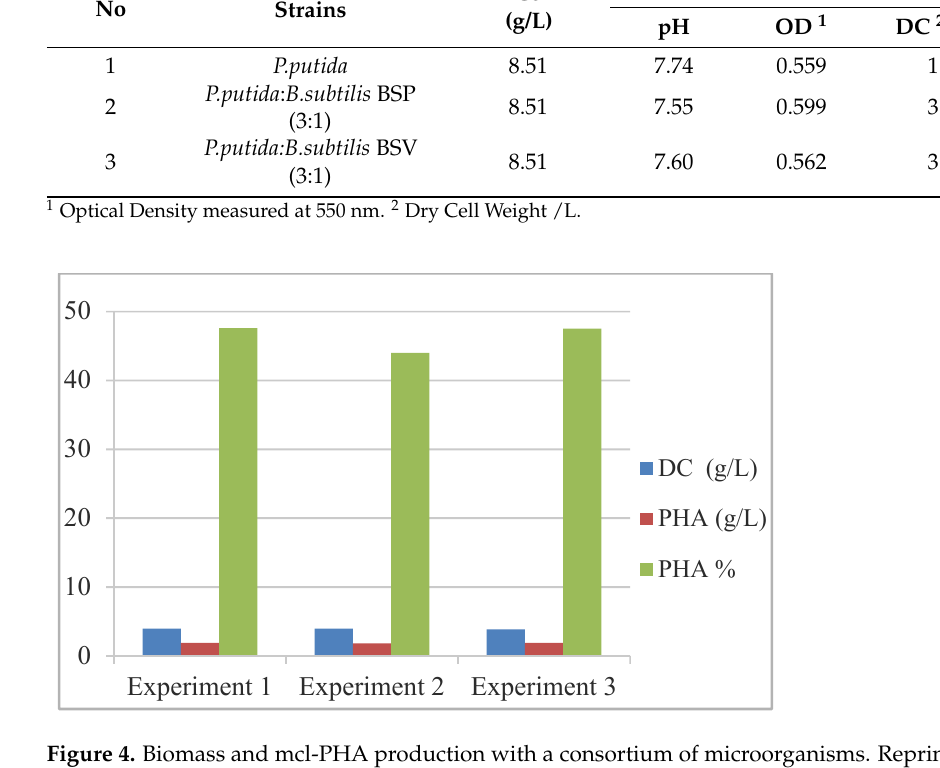
Figure 4. Biomass and mcl ‐ PHA production with a consortium of microorganisms. Reprinted with permission from ref. [68], 2016, Eremia et al., Ovidius Univ. Ann. Of Chem.